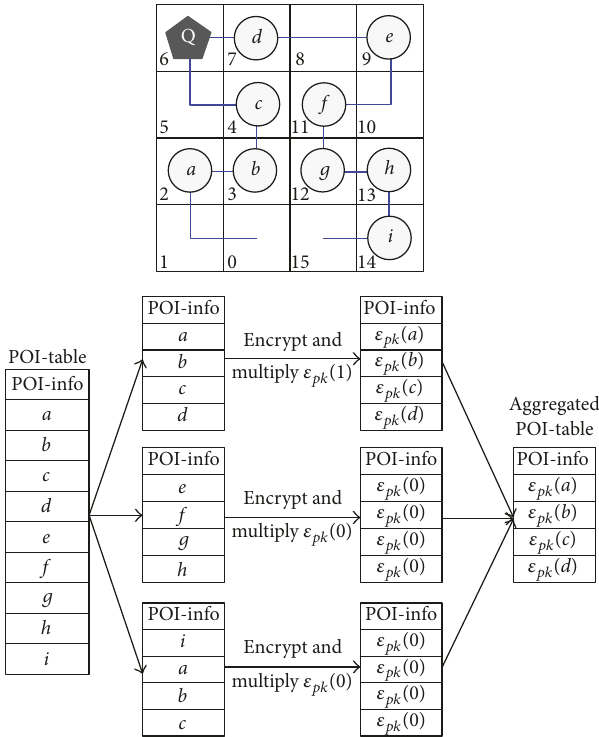
Figure 4: Example of aggregating